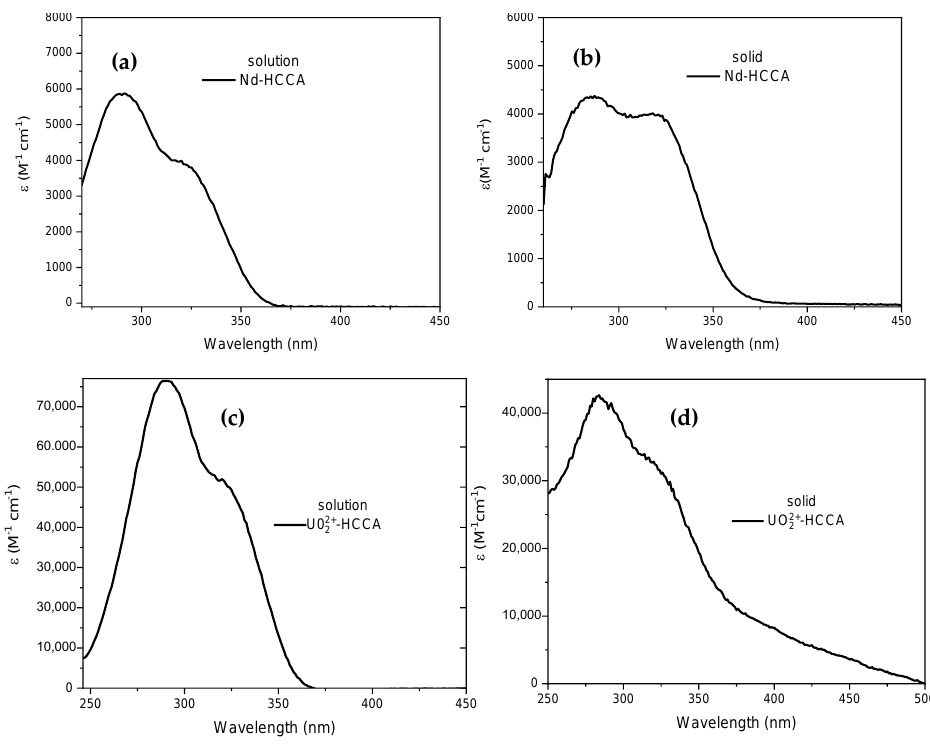
Figure 6. Absorption spectra of ( a , b ) neodymium-HCCA and ( c , d ) uranyl-HCCA. complexes, ob- tained by analyzing solution and solid, respectively.